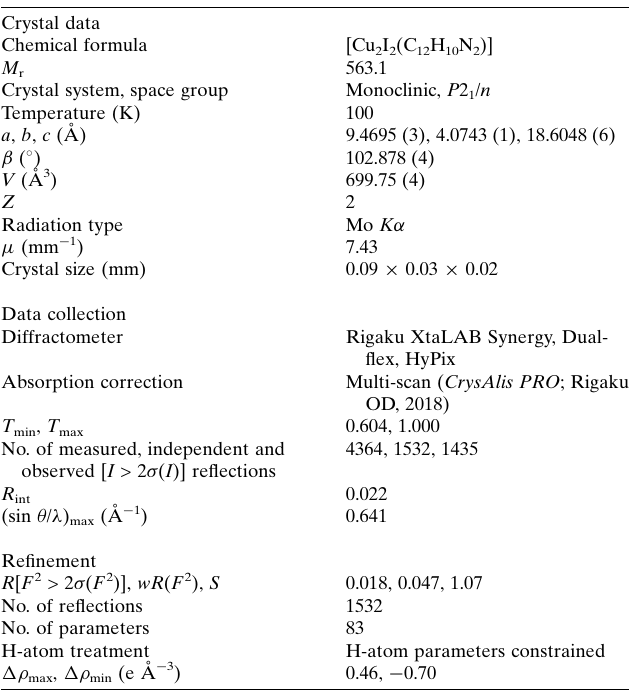
Table 2 Experimental details.